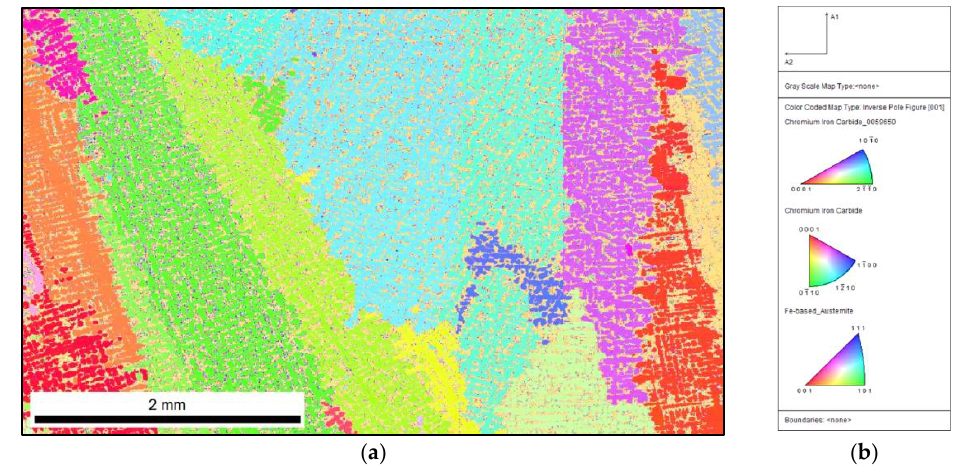
Figure 5. Reference sample: ( a ) IPF map with marked primary grains; ( b ) reference triangle.